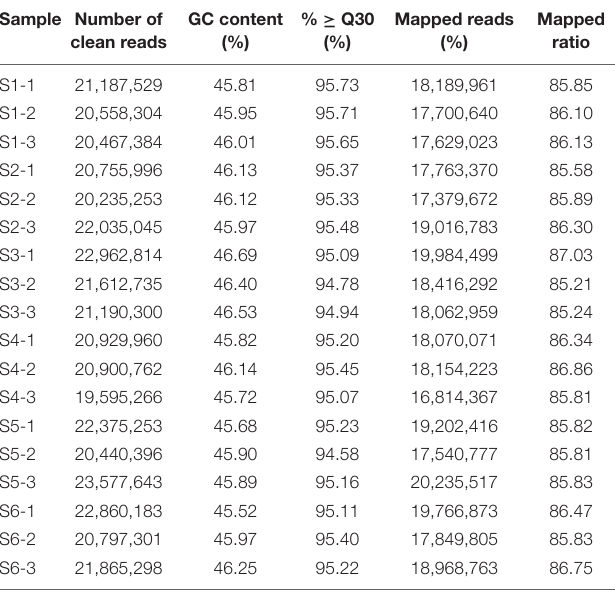
TABLE 1 | Sequencing statistics of Cymbidium sinense transcriptome during ovary development. Sample Number of GC content clean reads